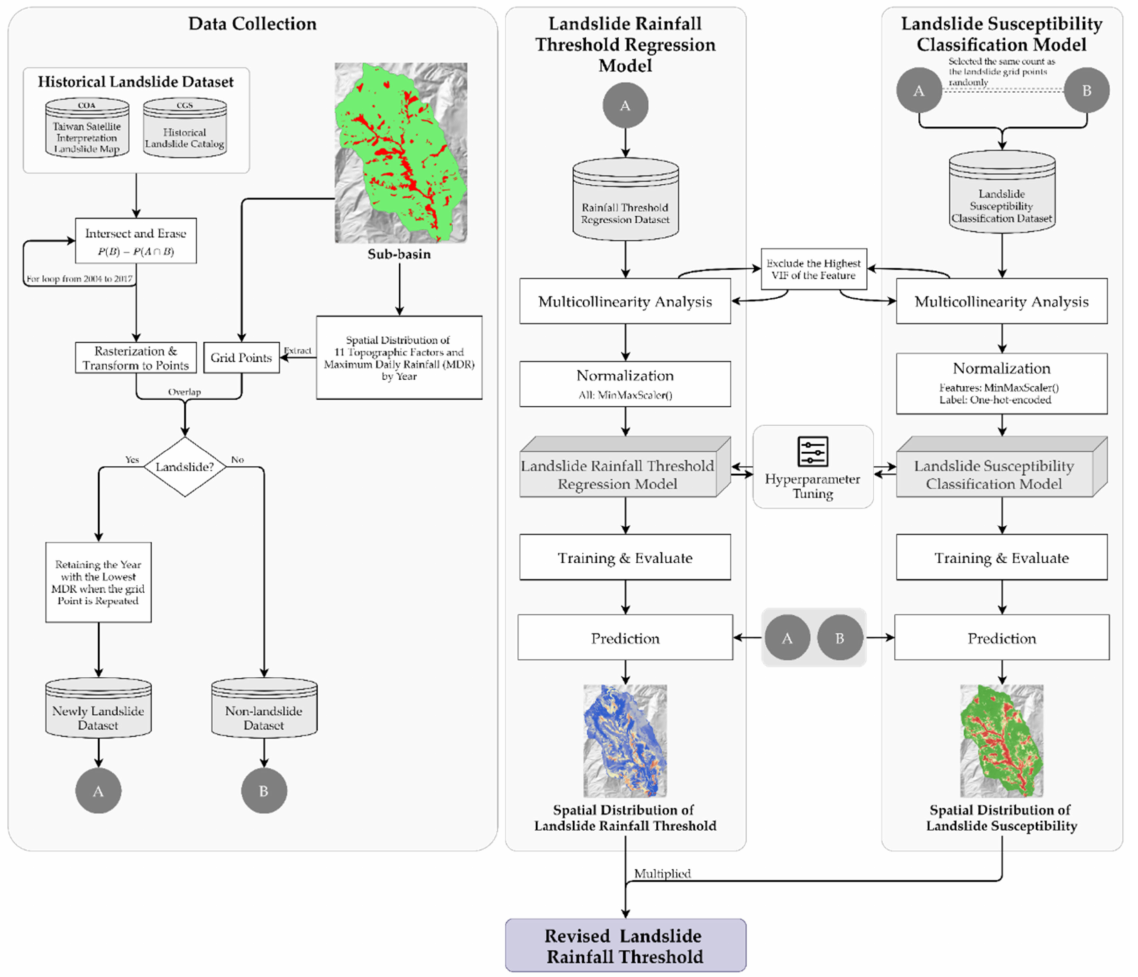
Figure 1. Study workflow for the prediction